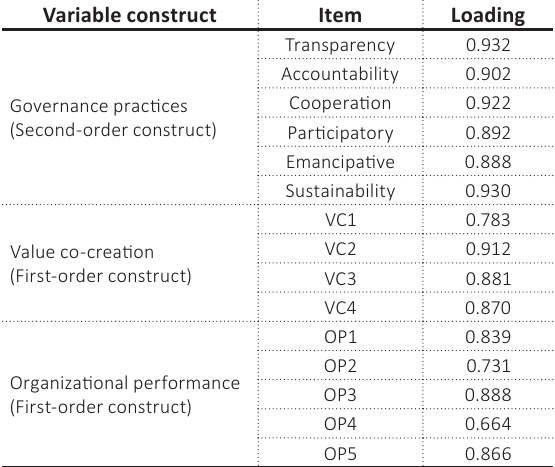
Table 4. Outer model